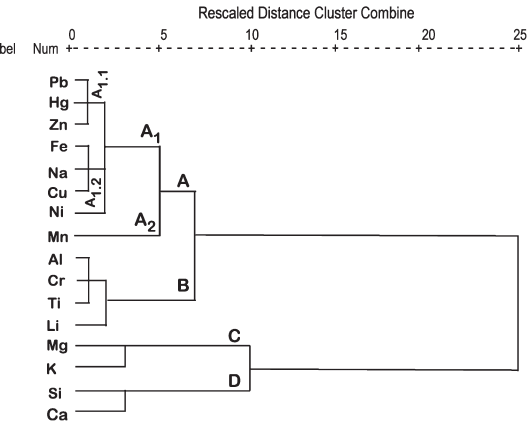
values not considered for determination of sediment accumulation rates.